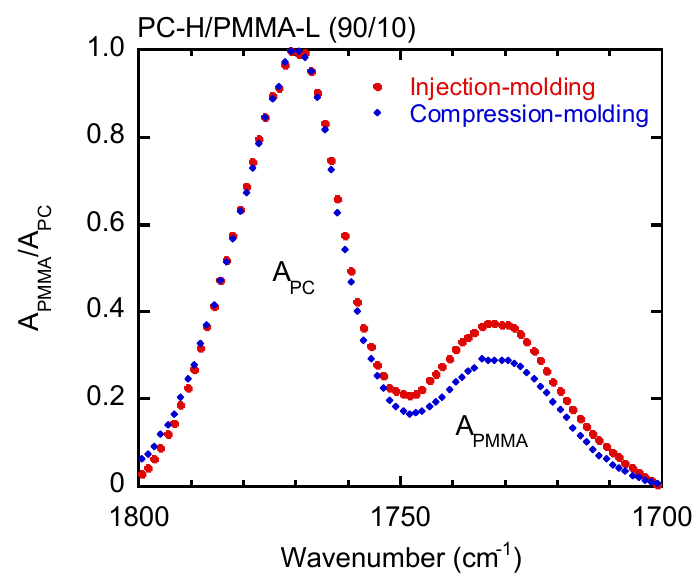
Figure 9. Normalized ATR-IR spectra of PC-H/PMMA-L (90/10) samples prepared by (circles) injection molding and (diamonds) compression molding.